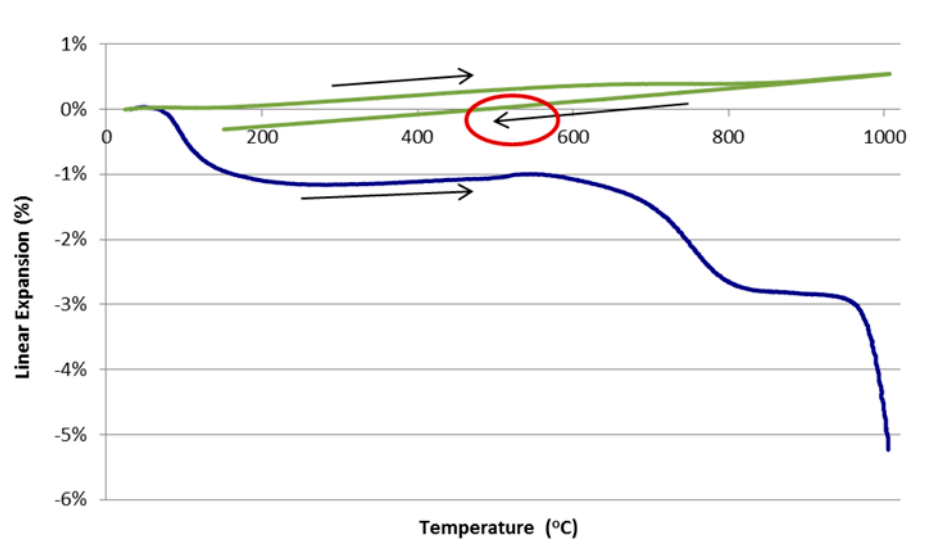
Figure 2. Dilatometer curves for C1.82 paste (blue) and HTC 6A composite (green). The composite curve shows both heating and cooling cycles as indicated by the direction of the arrows.